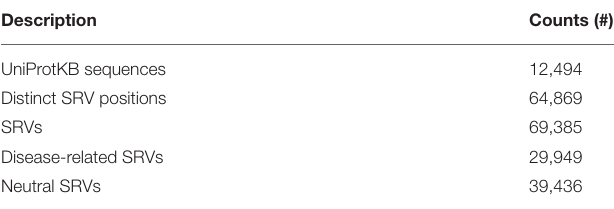
TABLE 2 | Statistics of HVARSEQ dataset.